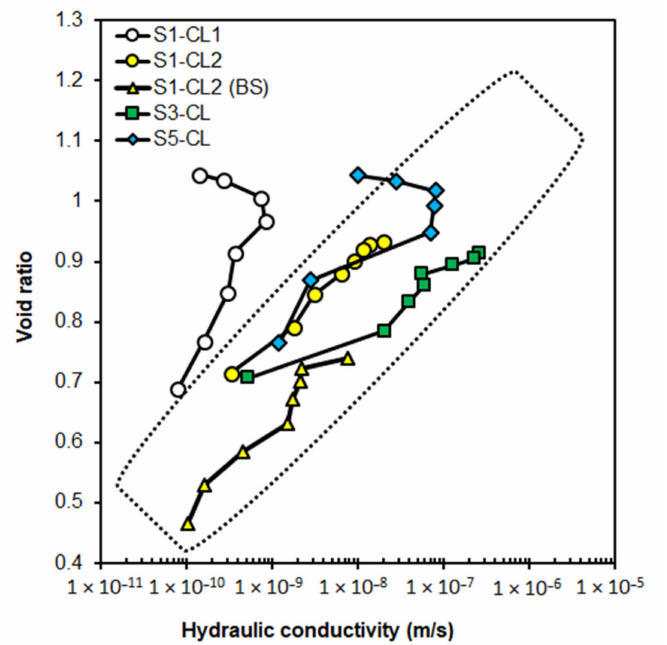
Figure 12. Results of the consolidation tests for CL soils from different